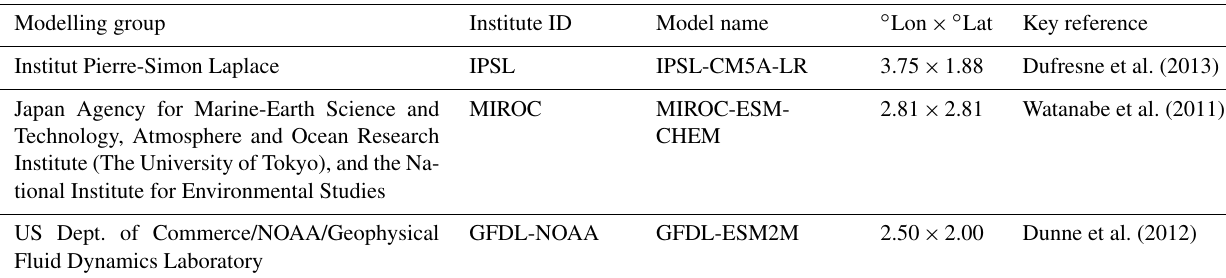
Table 1. Information on the GCMs used for this study. Modelling group Key